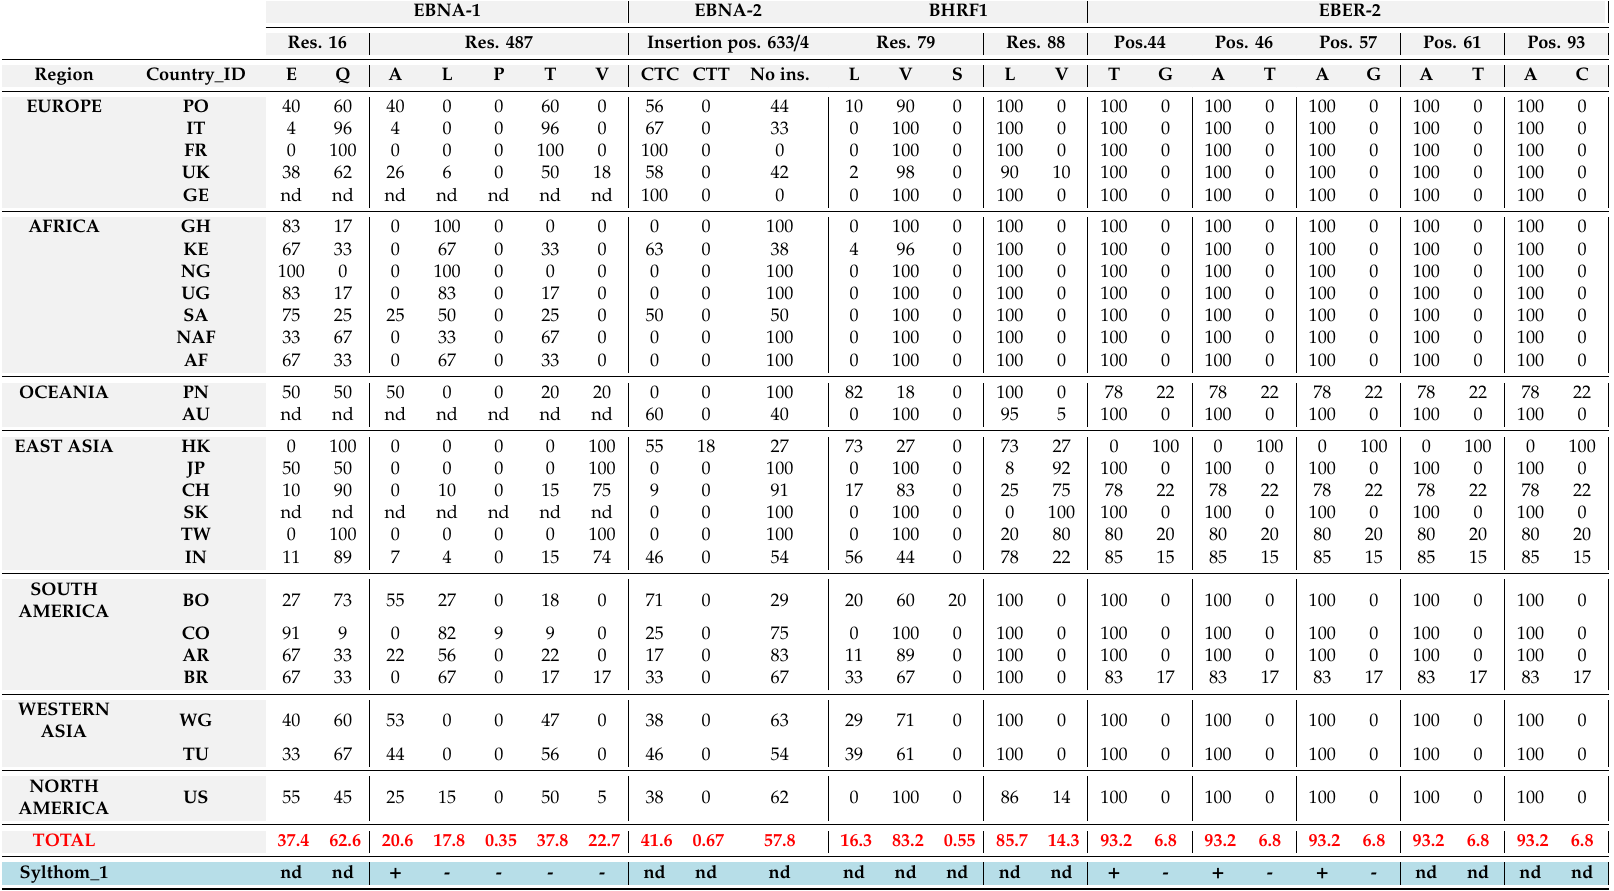
Table 3. Geographical variation distribution. The main typing variation described for EBV is summarised in this table as intra-population percentages. The countries for which specific variants were not described present a “nd” (i.e., no data). The ancient isolate “Syltholm_1” is reported at the end of the